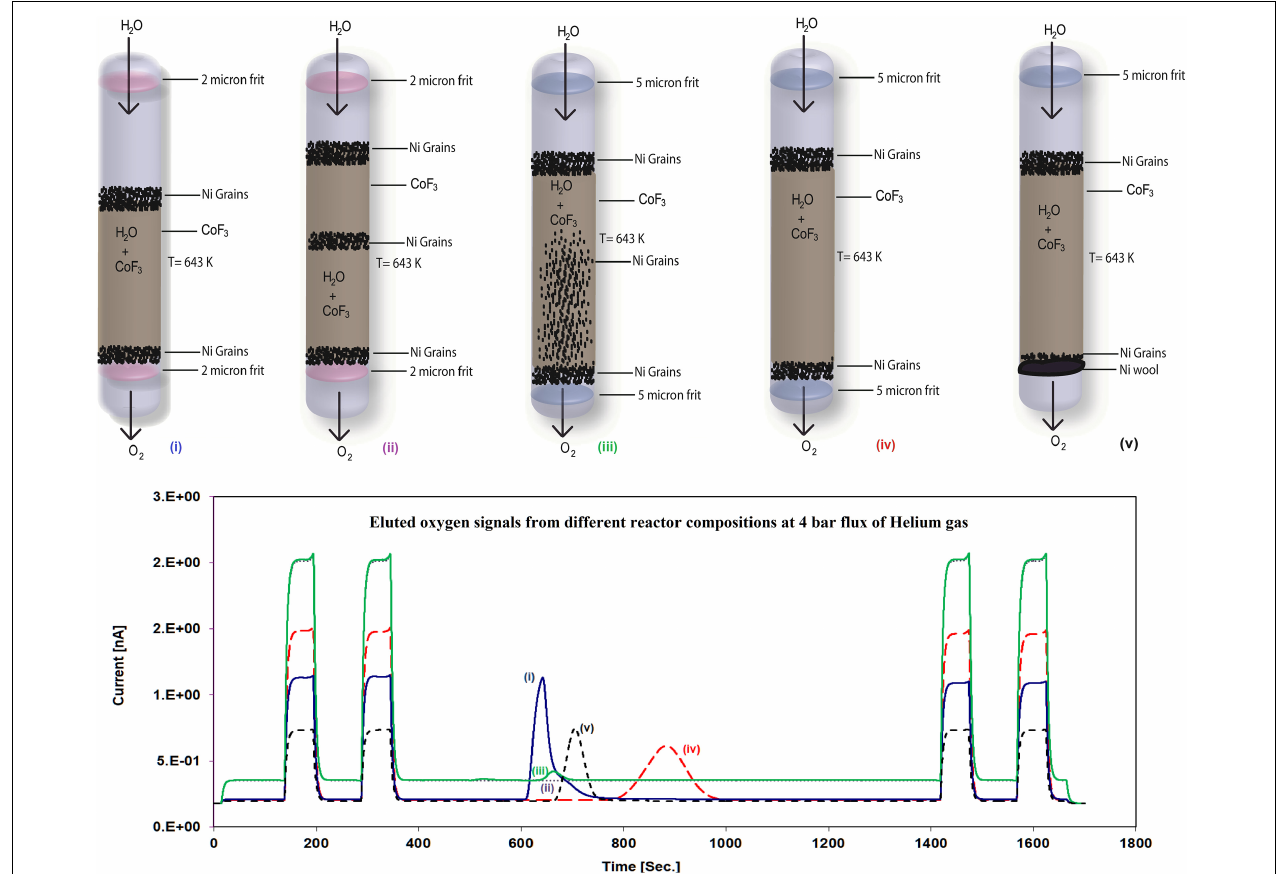
FIGURE 4 | The different reactor compositions (upper panel) and the corresponding evolution of the O 2 signal (mass 32, lower panel) dependent on the reactor compositions (The number (i–v) in the upper and lower panel corresponds to the different reactor setup and its associated eluted O 2 peak after chemical reaction from the corresponding reactor). The higher the compactness of the reactor (peak color and peak number color corresponds to the reactor number), the lower the eluted O 2 signal, and at the same time, higher compactness leads to the higher reference signals because of an increased dilution